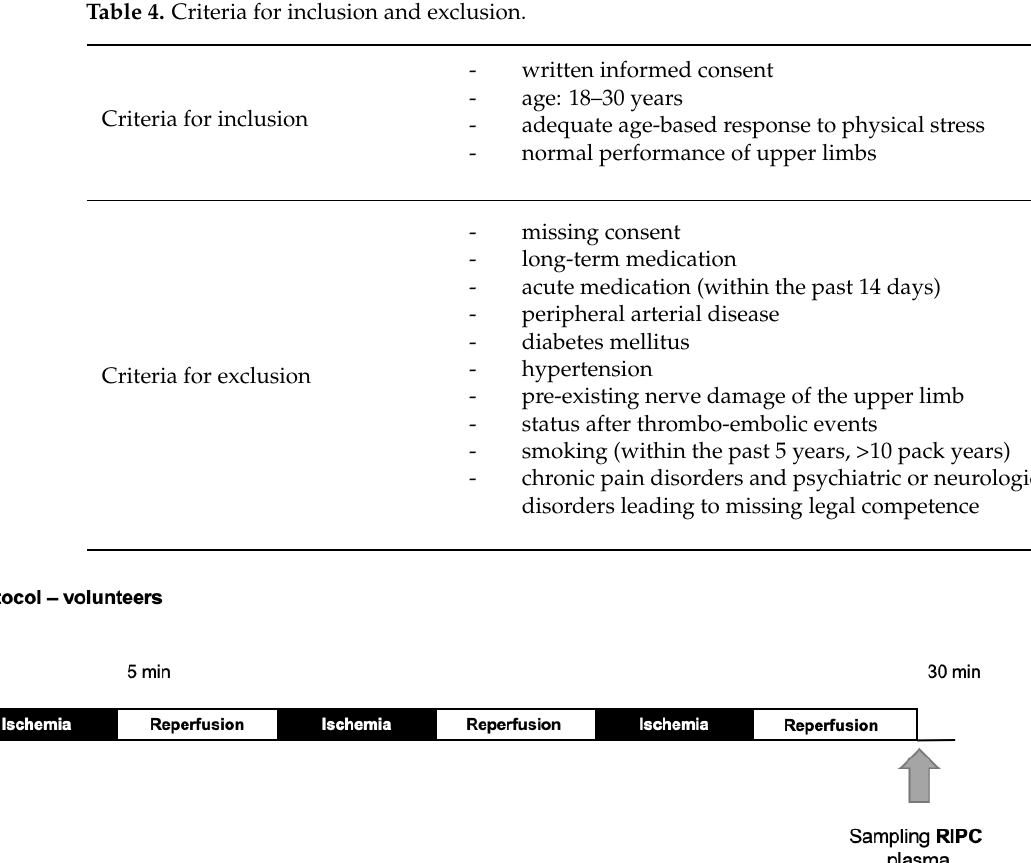
Table 4. Criteria for inclusion and exclusion.